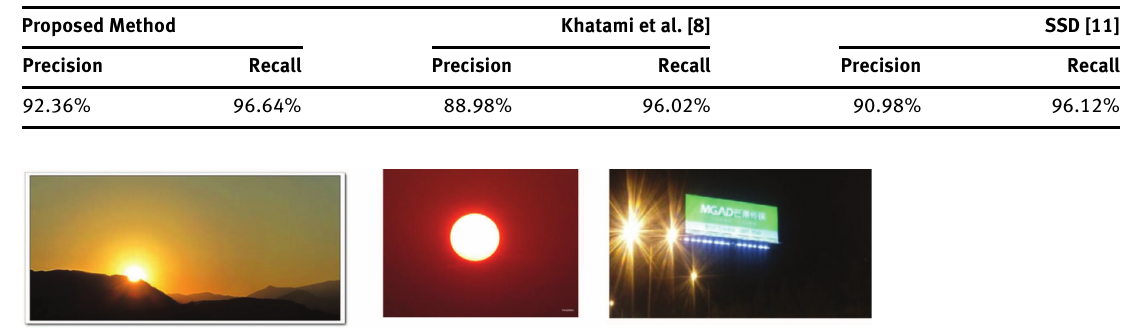
Figure 16: Some Successfully Discriminated Samples by Our